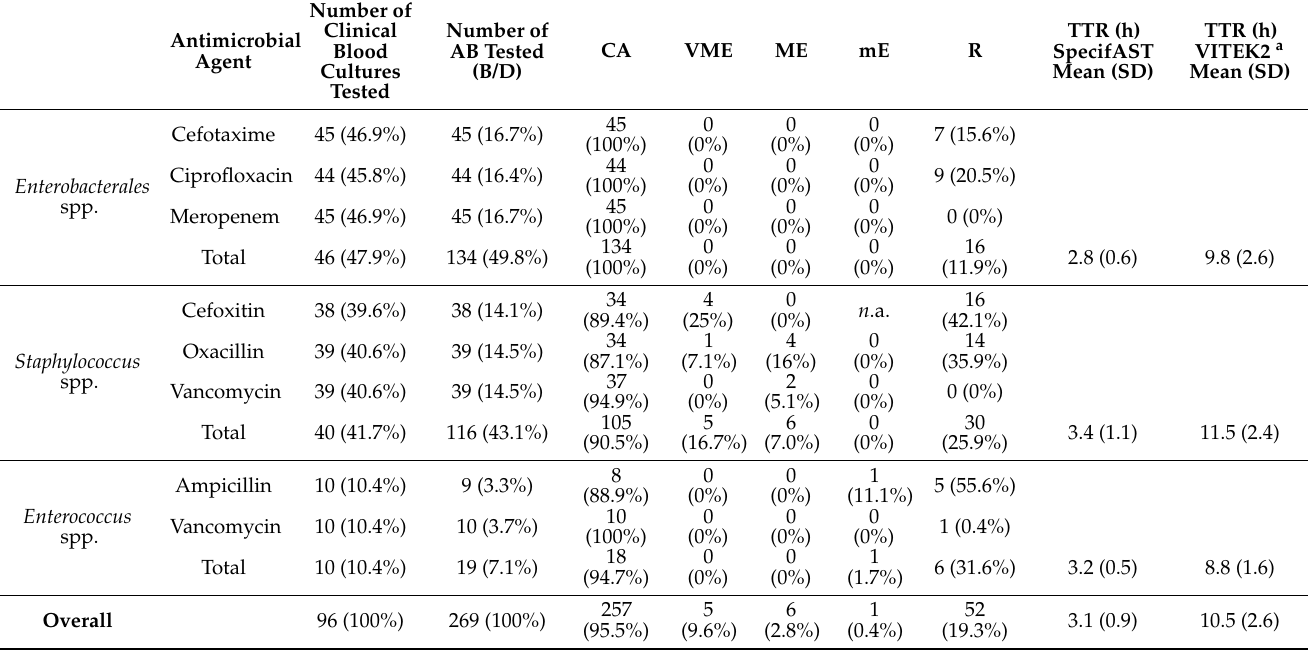
Table 3. Number and percentages of categorical and essential agreement between SpecifAST ® and VITEK2 ® AST results, corresponding error rates and percentages, resistance rates, and time to test results per micro-organism group and antimicrobial